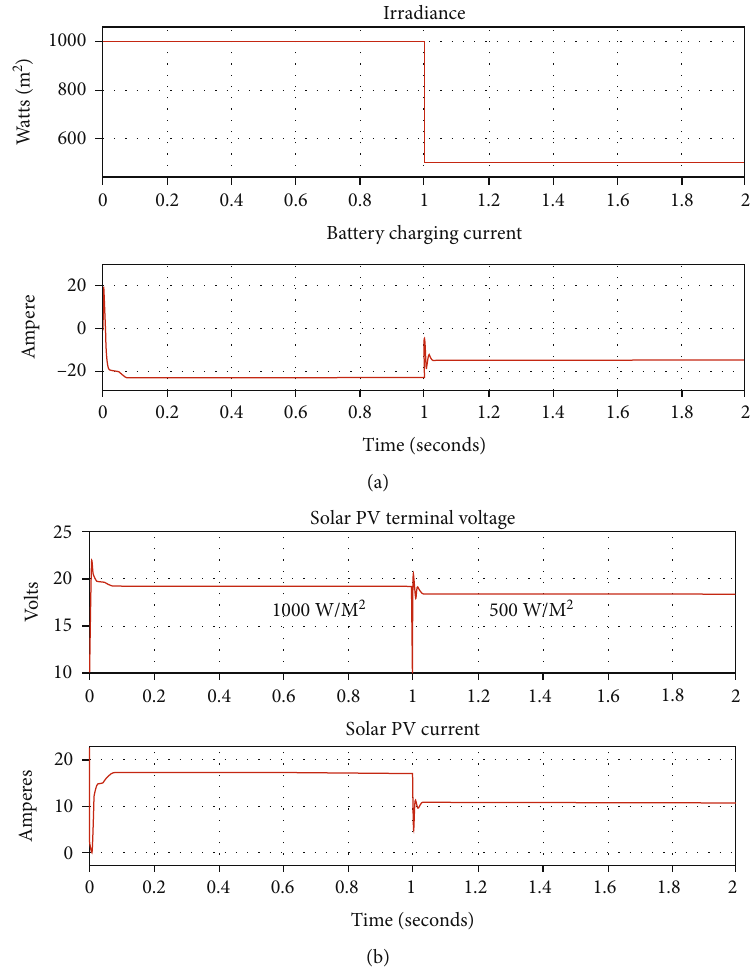
Figure 17: (a) Irradiance and charging current. (b) SPV voltage and current.